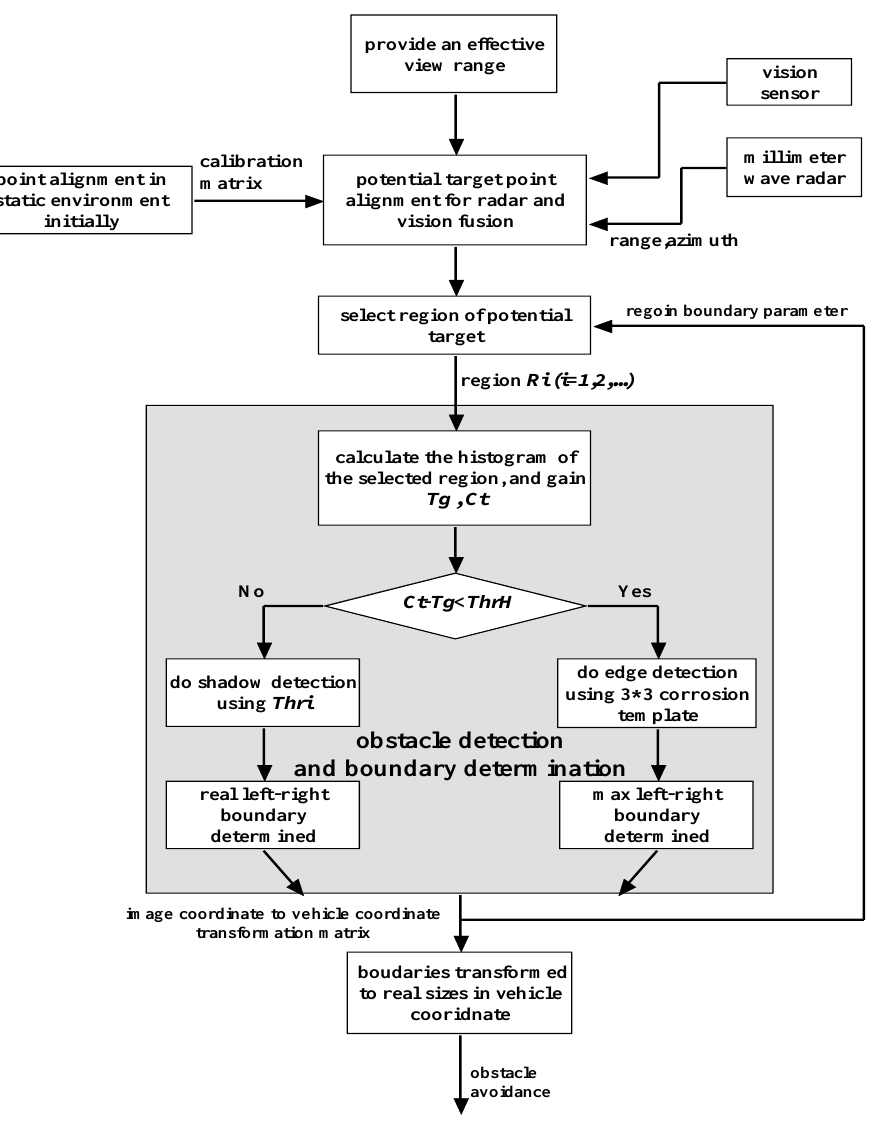
Figure 8. Flow diagram of obstacle detection algorithm using radar and monocular vision fusion.